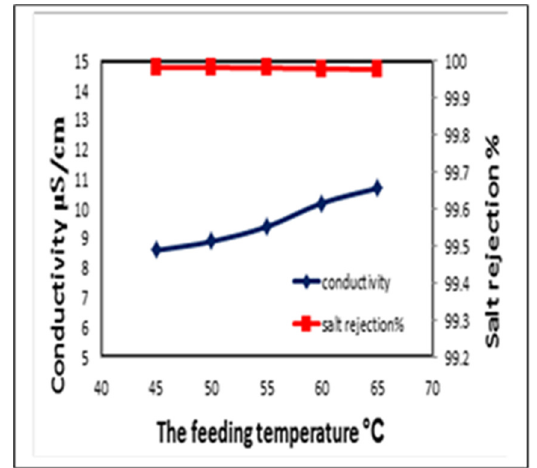
Fig. 5. Effect of the feeding temperature on the permeate conductivity and salt rejection at 35 g/L Nacl, and 1.07 L/min feed flow rate